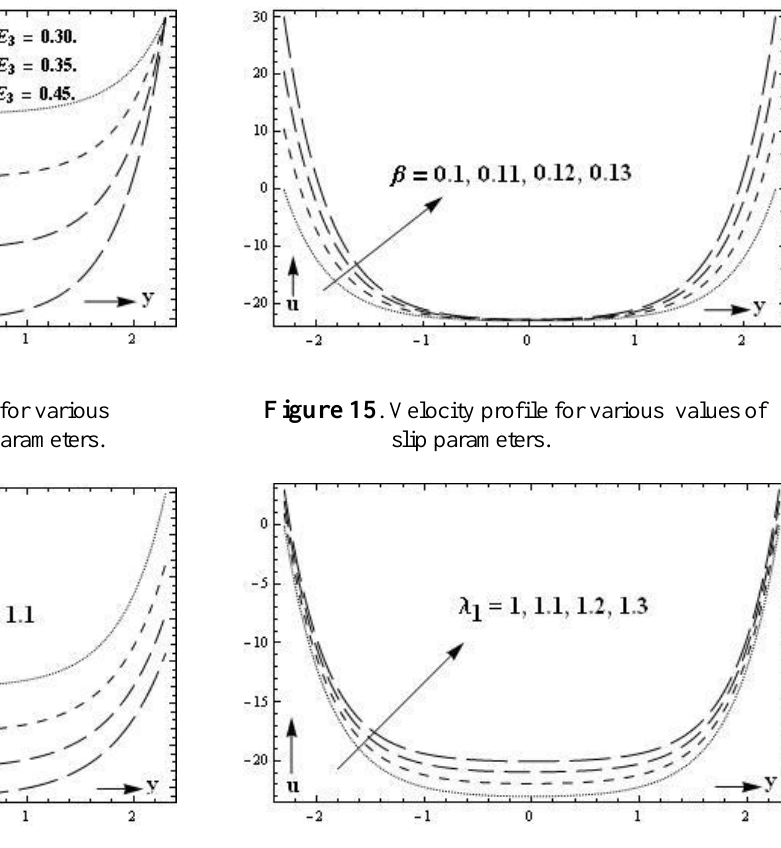
Figure 17. Velocity profile for various values of Jeffrey parameters.